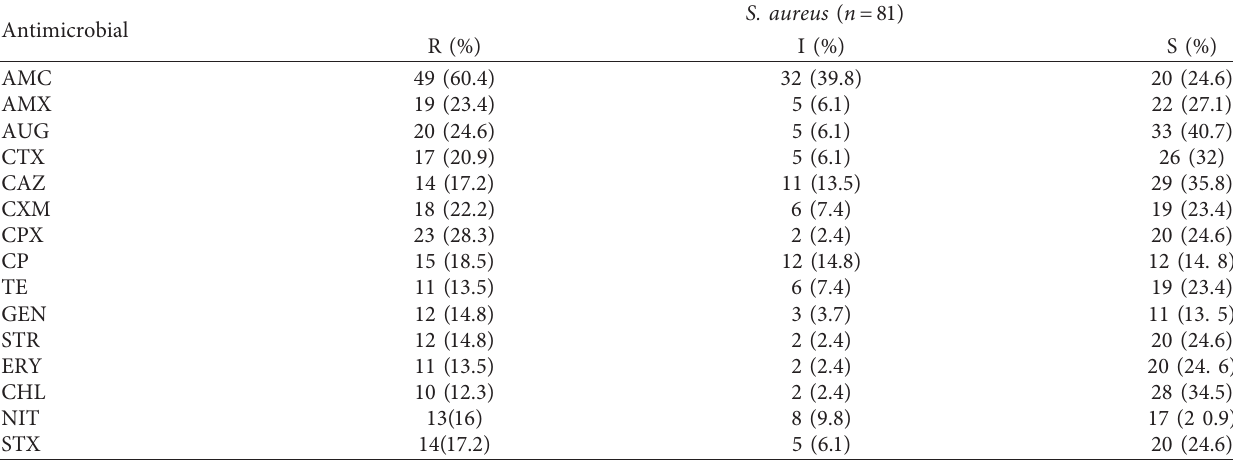
Table 3: Antibiotics sensitivity of Gram-positive bacterial isolates from teat milk samples, drinking water samples, and fecal swabs isolates from cattle’s and buffaloes. Antimicrobial